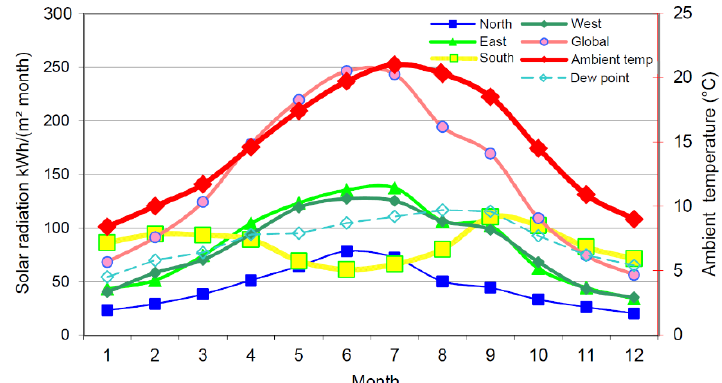
Figure 1. Solar radiation and outdoor temperature, monthly average. Climate Santiago, Chile. Note: For this study month 1 is July and month 7 is January. Data extracted from simulation in Passive House Planning Package (PHPP).